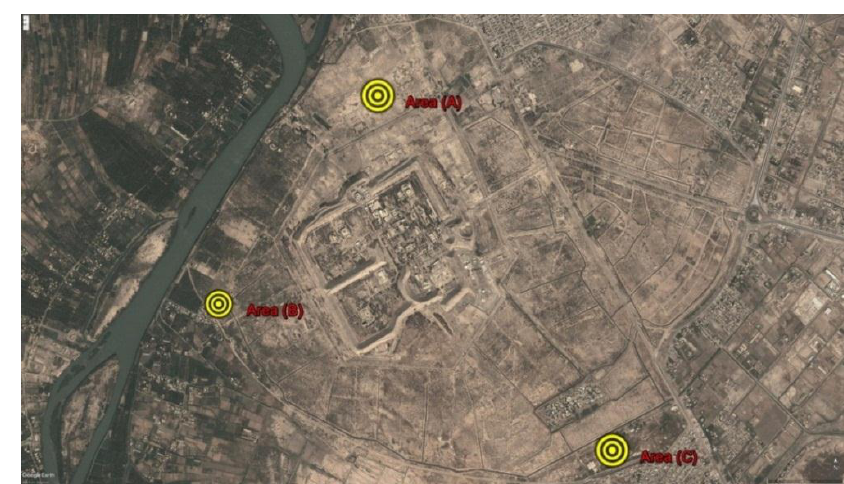
Fig. 2: Location of contamination areas in yellow circles which are clearly above background concentration. Area A includes samples S-8 and S-9, area B includes samples S-24, S-25and S-26, and area C includes samples S-29, S-30 and